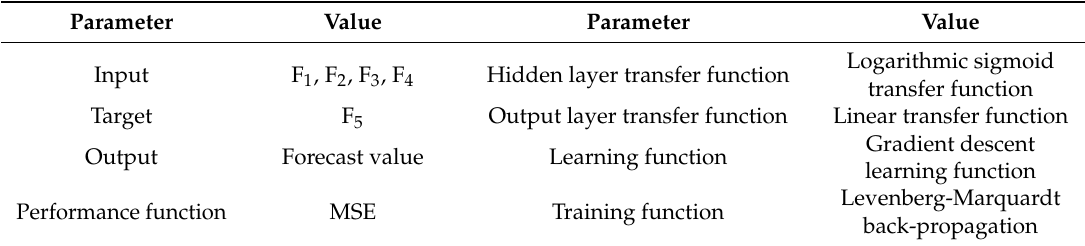
Table 4. Relative parameter settings before the training